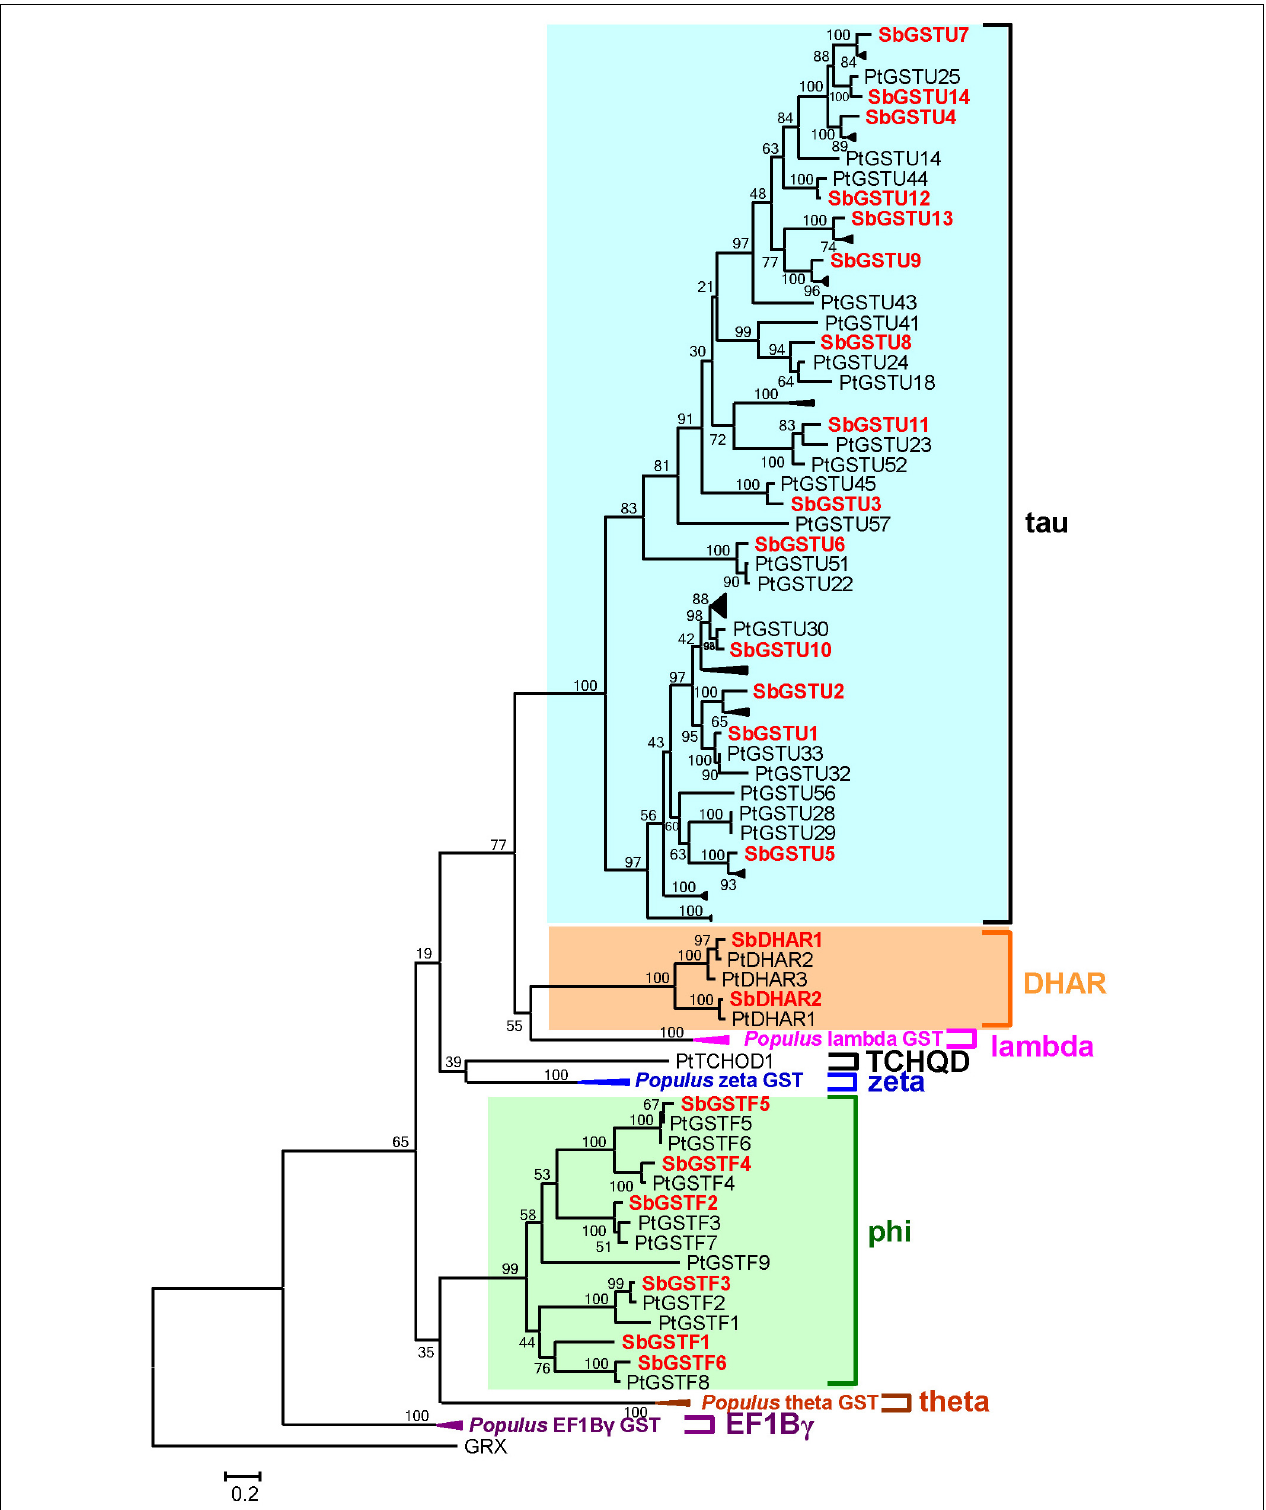
FIGURE 2 | Phylogenetic relationships between Salix and Populus GSTs. The tree was reconstructed with protein sequences using ML procedure with JTT model. Salix GSTs are represented by red letters.